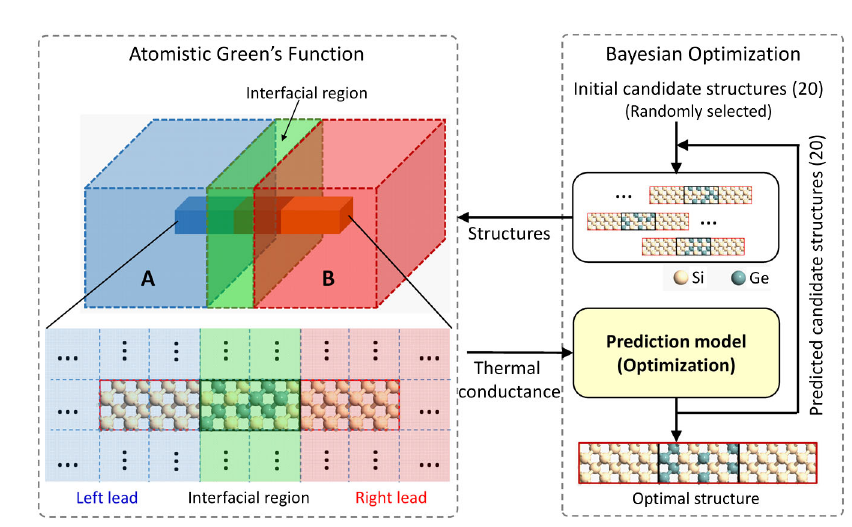
FIG. 1. Schematics of the materials informatics method combing the atomistic Green function (AGF) and Bayesian optimization. In the actual AGF calculation, the buffer region is installed between the interfacial region and the lead, which is omitted in the sketch for